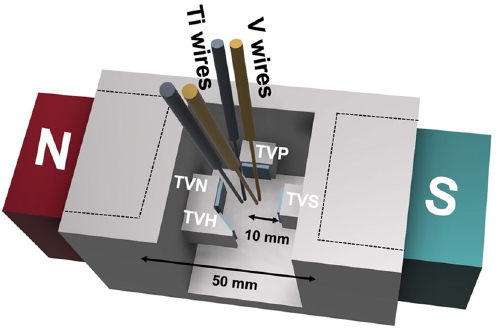
Figure 1. Schematic diagram of the sparking method under various magnetic flux